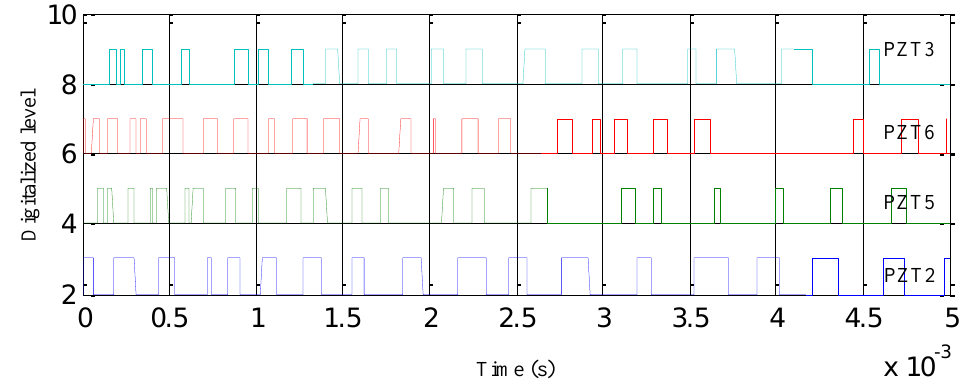
Figure 7. Typical digital sequences acquired by the digital